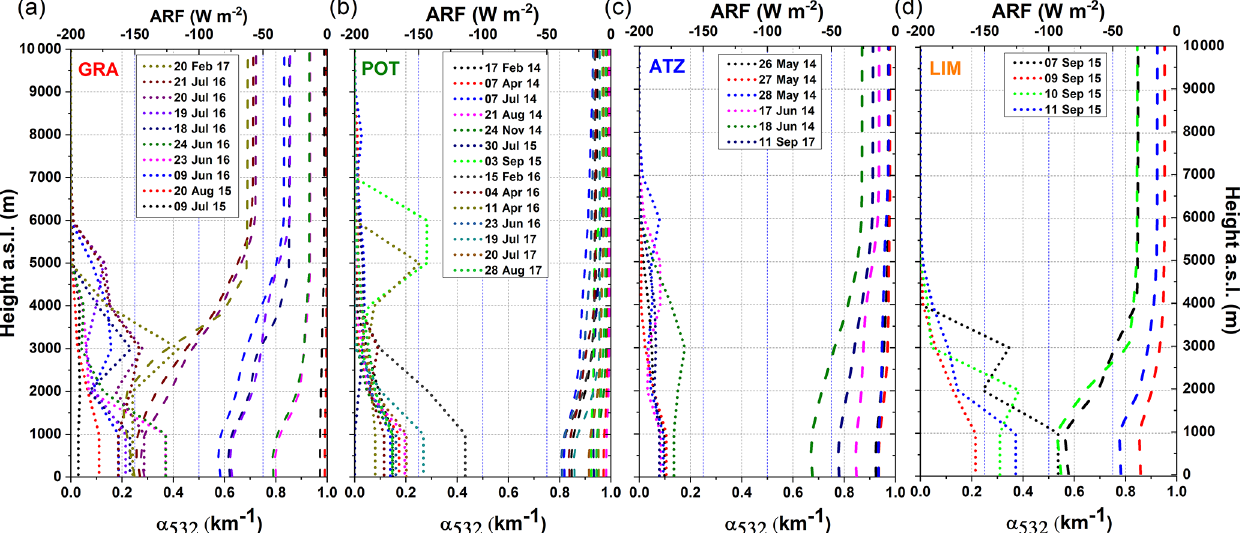
Figure 10. Vertical profiles of α 532 (dotted lines) calculated from Raman lidar measurements along with the SW ARF (dashed lines) esti- mated from libRadtran simulations for the sites of (a) Granada, (b) Potenza, (c) Athens and (d) Limassol, at 45 ◦ SZA.